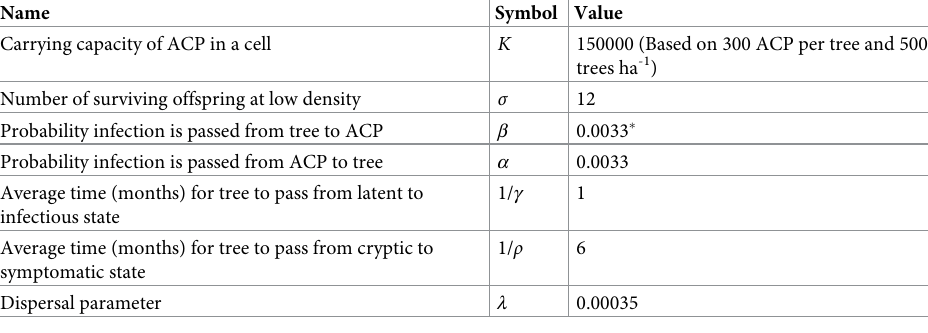
Dispersal parameter λ